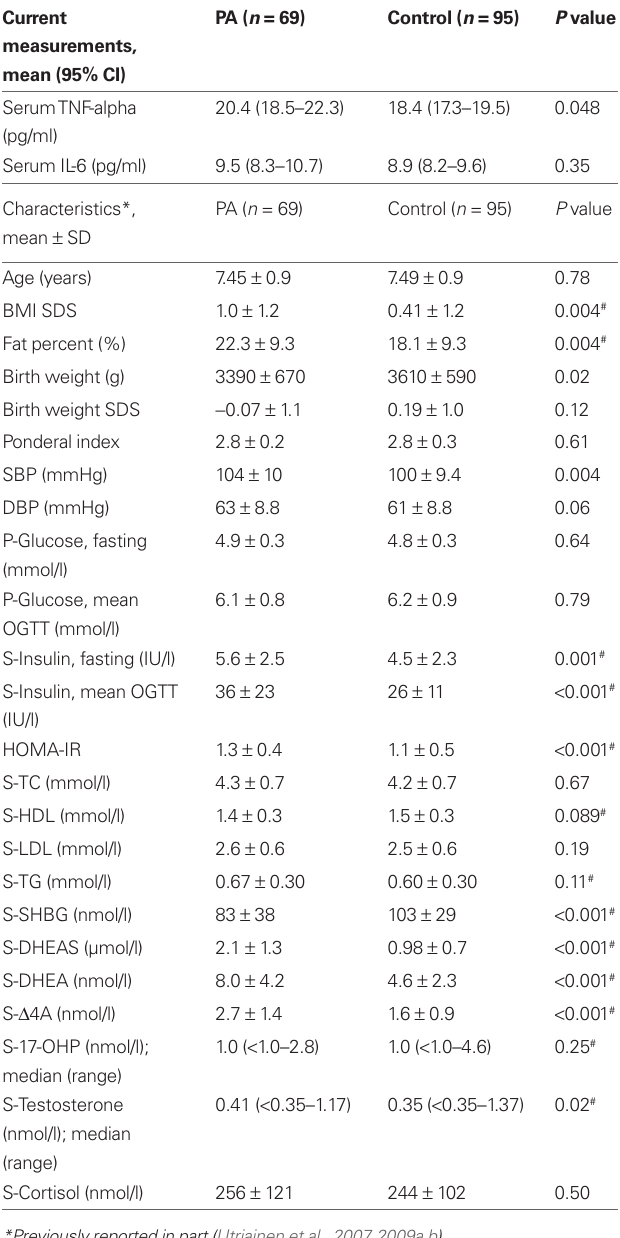
Table 1 | Biochemical and anthropometric characteristics of children with signs of premature adrenarche and those of prepubertal control